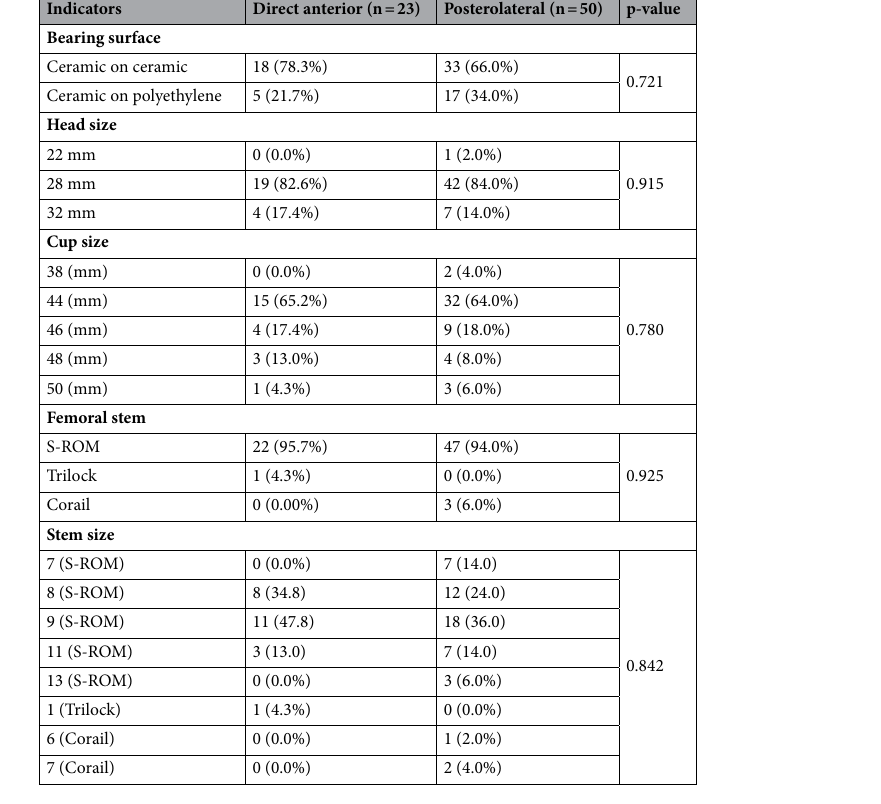
Table 2. Implants parameters of the two study